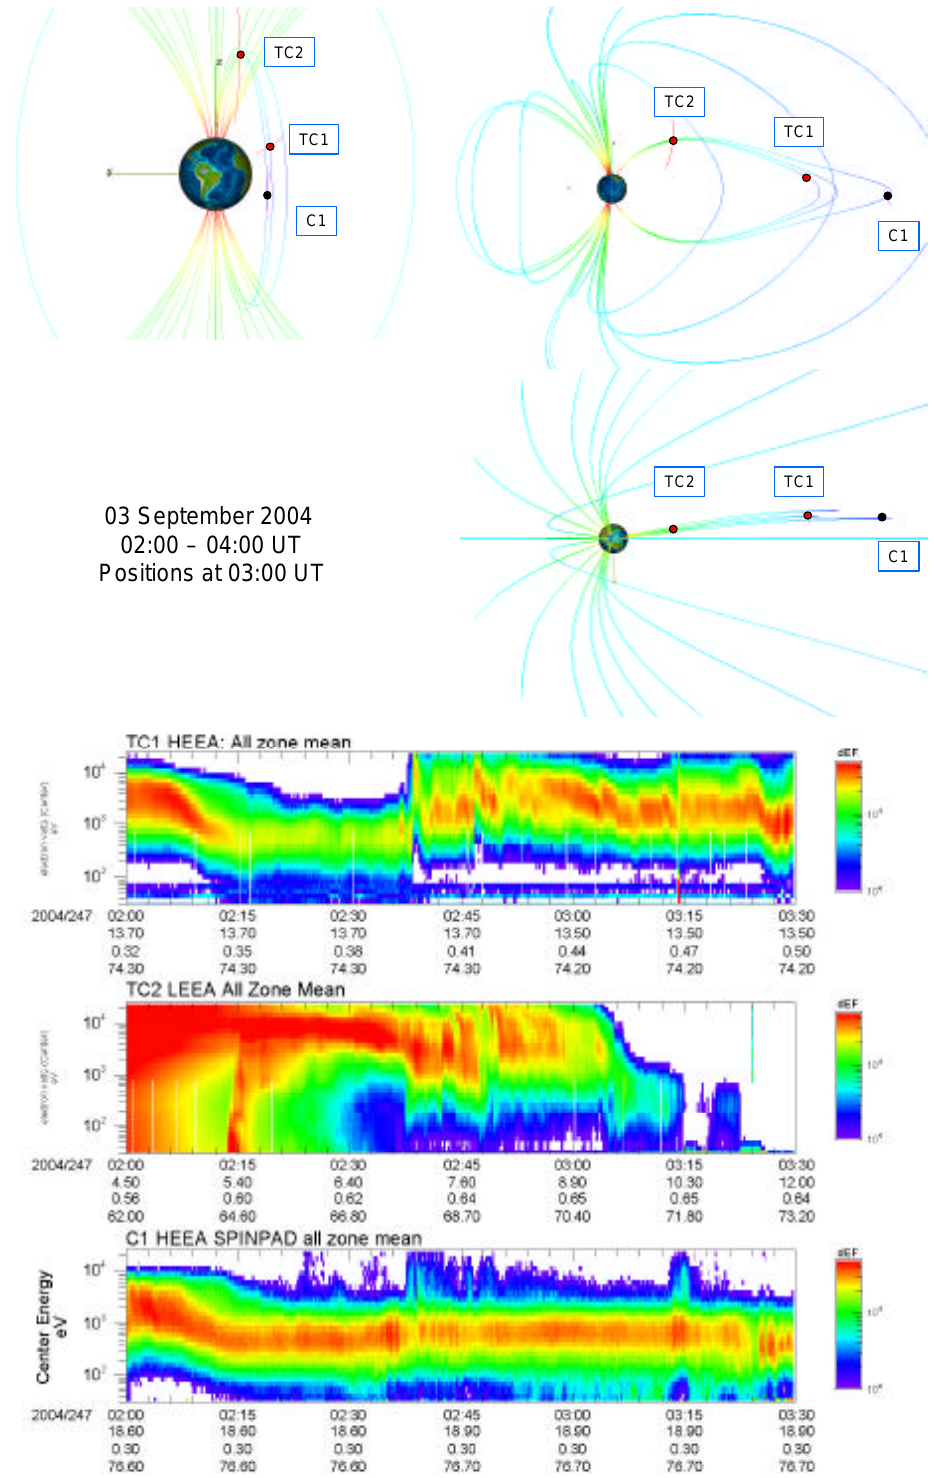
Fig. 15. Above, 3 September 2004, orbital positions and OVT model magnetosphere in GSM, views from − X, Y and Z; below, PEACE data from TC-1, TC-2 and C4. X-axis labels show UT time, L-shell, MLT and invariant Figure 15: above, September 03 rd 2004, orbital positions and OVT model magnetosphere in GSM, views from –X, Y and Z; below, PEACE data from TC1, TC2 and C4. X-axis labels show UT time, L-shell, MLT and invariant latitude.